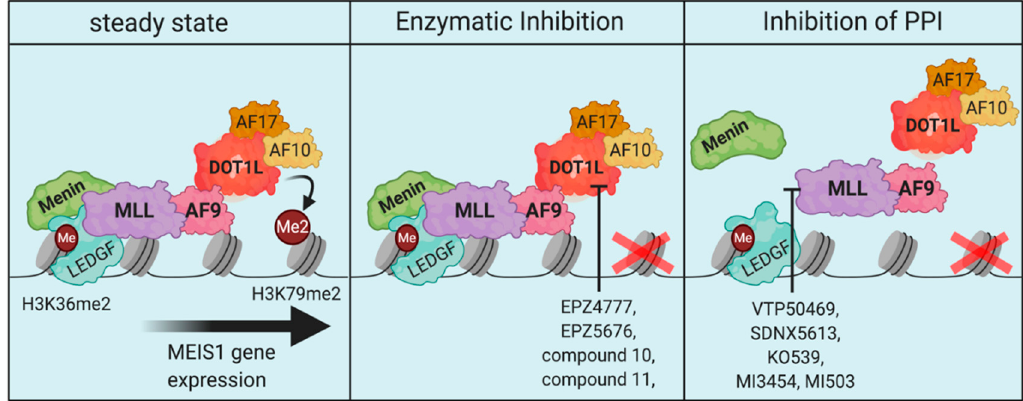
Figure 4. Schematic comparison between the consequences of DOT1L- and Menin-inhibition for the integrity of the MLL-AF9 complex on chromatin. The intact MLL-AF9 complex stably binds to its target genes via Menin and recruits the DOT1L-complex to drive H3K79me2 and gene expression of canonical targets (e.g., MEIS1) ( left ). DOT1L-inhibition removes H3K79me2 by blocking the enzymatic activity of the methyltransferase, while leaving the complex largely intact ( middle ). Inhibition of the menin-MLL1 interaction disrupts the integrity of the MLL-AF9 complex on chromatin, leading to a more rapid and profound response ( right ).